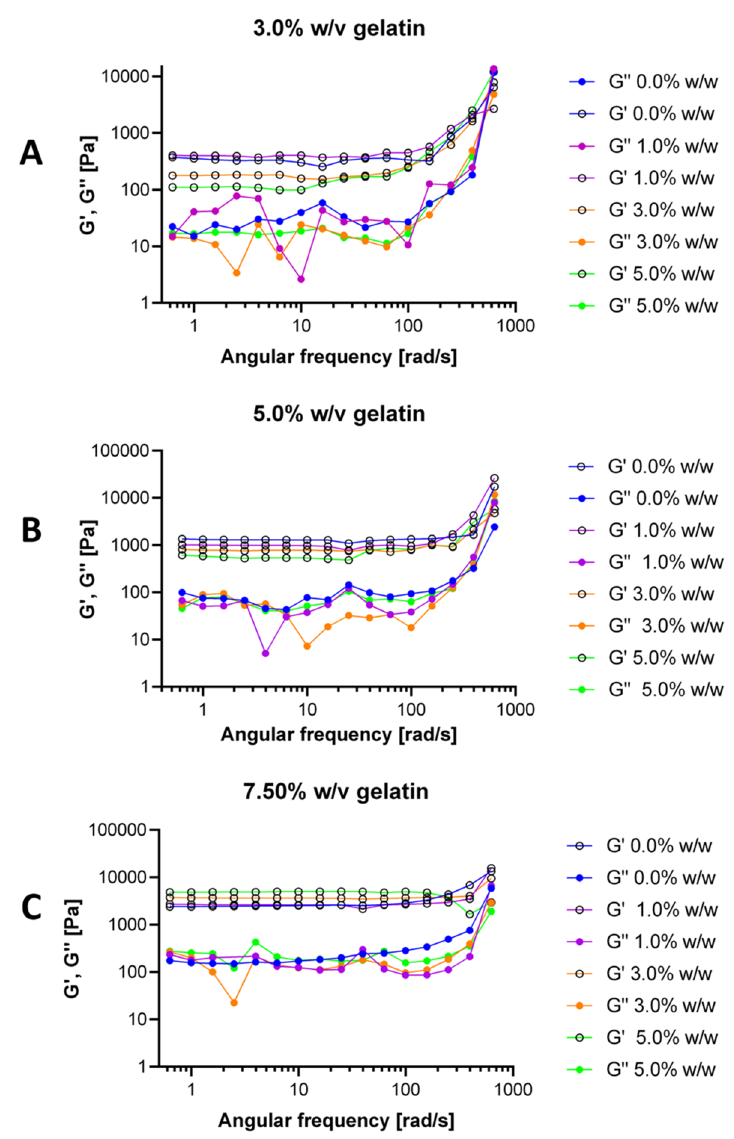
Figure 5. Storage and loss moduli for 3.0% ( A ), 5.0% ( B ) and 7.5% ( w/v ) ( C ) gelatin and for concentrations of GTA of 0.0%, 1.0%, 3.0% and 5.0% ( w/w